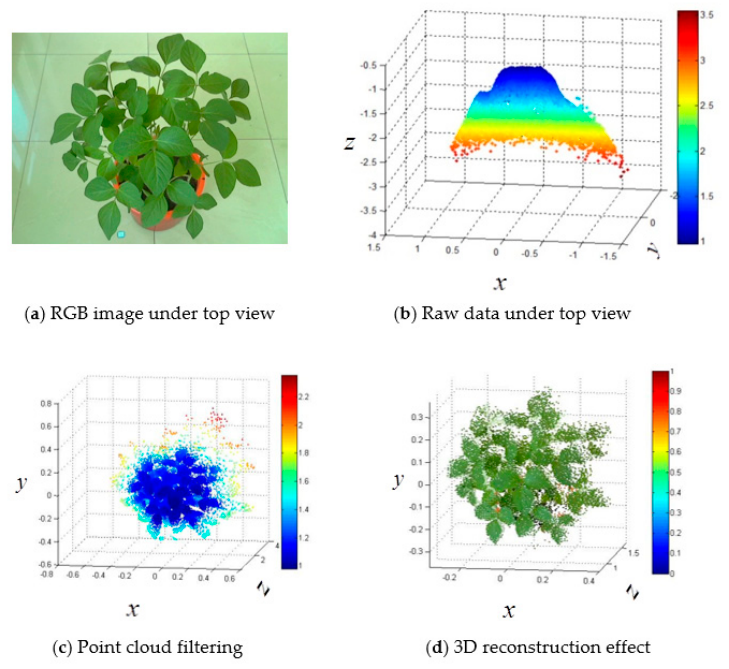
Figure 9. Reconstruction results of soybean in the top view.